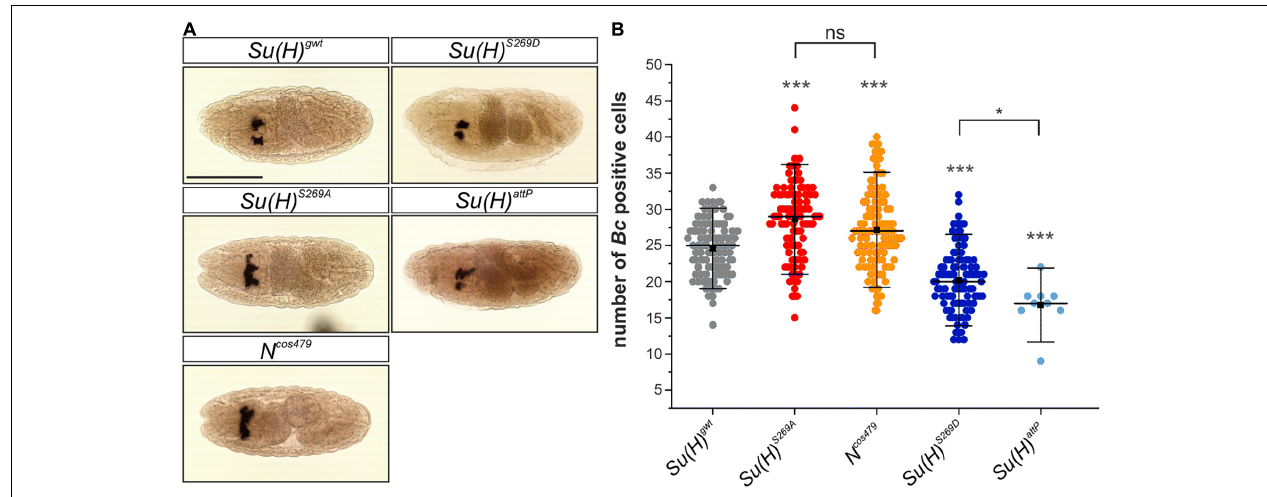
FIGURE 4 | Embryonic crystal cell number is affected in Su(H) phospho-mutants. (A) Dorsal view of stage 14–16 embryos stained with a DIG-labeled Bc cDNA probe. The embryos were derived from germ line clones. Crystal cell precursors develop in bilateral clusters. Scale bar represents 200 µ m for all panels. (B) Quantification of Bc positive cells in a total of 100 embryos of each genotype except for Su(H) attP ( n = 9). Individual data points are indicated. Mean is shown as a black square, the median as horizontal bar. Error bars represent ± s.d. Highly significant differences are relative to control Su(H) gwt (in gray); *** p < 0.001; * p < 0.05; ns (not significant) p > 0.05; two-tailed Tukey-Kramer test. Su(H) S 269 A und N cos 479 / + mutant embryos harbored more Bc positive cells in the clusters, whereas Su(H) S 269 D and Su(H) attP embryos were characterized by lower numbers.